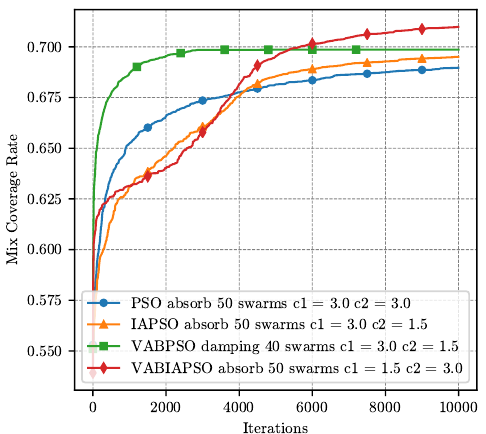
Figure 15. Performance comparison of four algorithms under the optimal parameters of the real scene with 4 sensors.